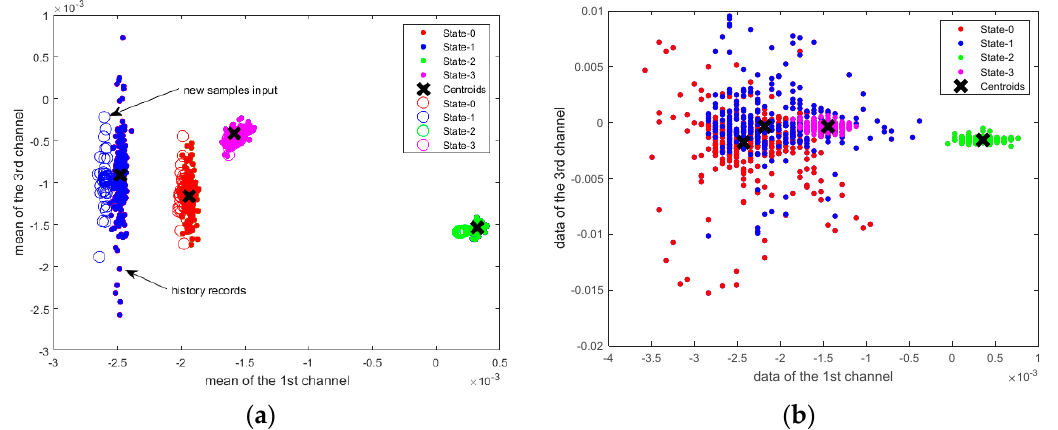
Figure 6. SHM classification using K-means. ( a ) Clustering of mean samples; ( b ) Clustering of raw data.